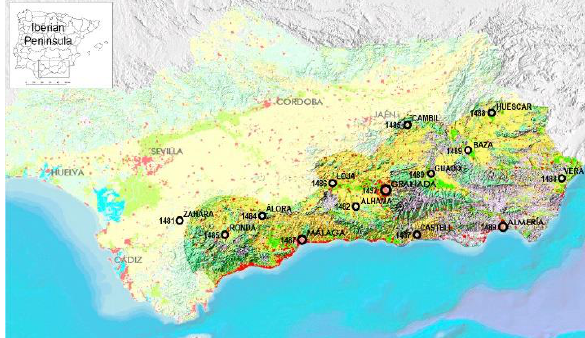
Figure 1. Main cities of the Nasrid kingdom that were sieged and conquered by the Christians during the War of Granada